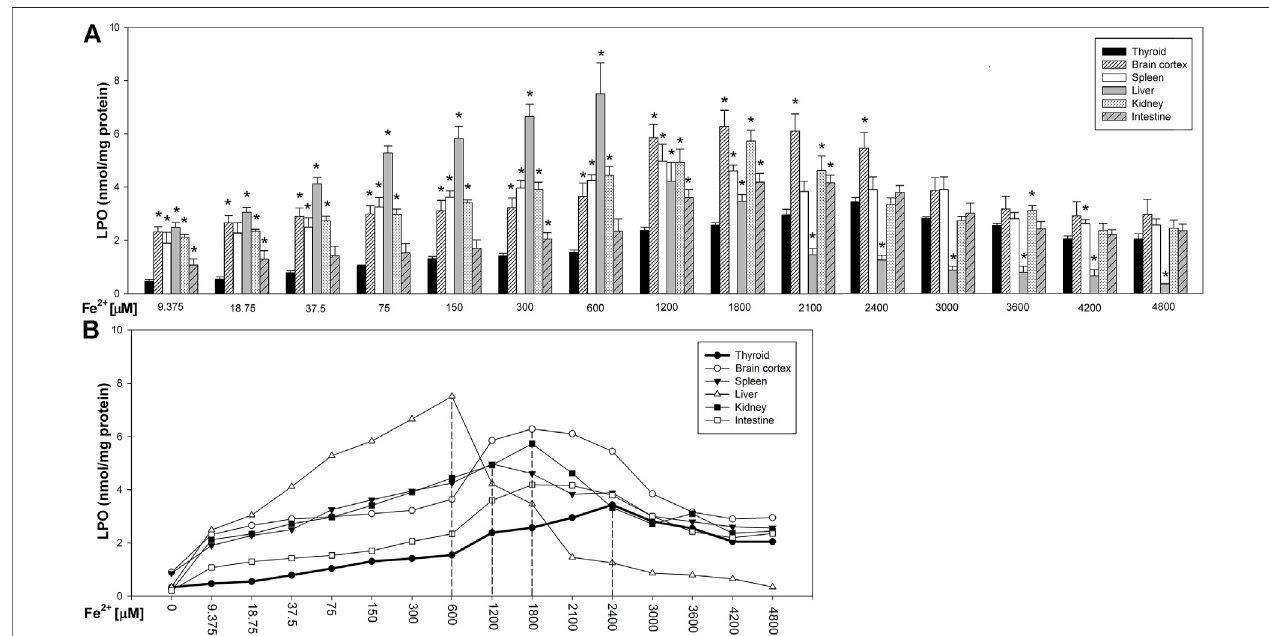
FIGURE3|(A) Concentrations oflipid peroxidation products (MDA+4-HDA) inthehomogenatesofporcinetissues (thyroid, braincortex, spleen, liver, kidney, and intestine), incubated with Fe 2+ (9.375, 18.75, 37.5, 75, 150, 300, 600, 1,200, 1,800, 2,100, 2,400, 3,000, 3,600, 4,200, and 4,800 µM) + H 2 O 2 (5 mM). * p < 0.05 vs. respective concentration in the thyroid. (B) Line graph representing concentrations of lipid peroxidation products (MDA+4-HDA) in the homogenates of porcine tissues (thyroid, brain cortex, spleen, liver, kidney, and intestine), incubated with Fe 2+ (9.375, 18.75, 37.5, 75, 150, 300, 600, 1,200, 1,800, 2,100, 2,400, 3,000, 3,600, 4,200, and 4,800 µM) + H 2 O 2 (5 mM). Vertical dashed lines indicate that iron concentration at which the LPO peak occurs for each individual tissue. Data points represent mean values of independent experiments analogically to results presented in Figure 3